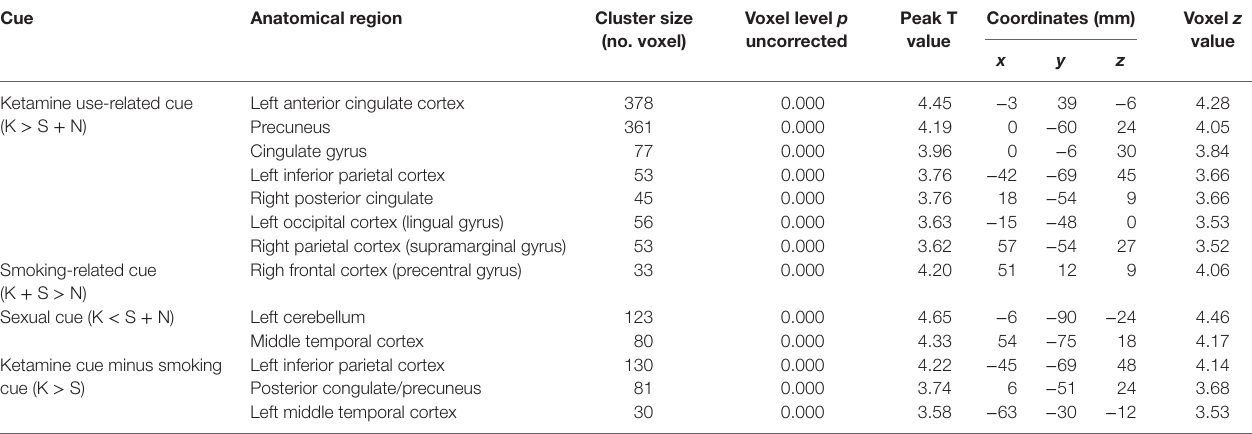
TaBle 2 | Regions of brain activation during exposure to ketamine use related films (40 ketamine users VS 45 smokers + 44 non-smokers), smoking (40 ketamine users/also smokers